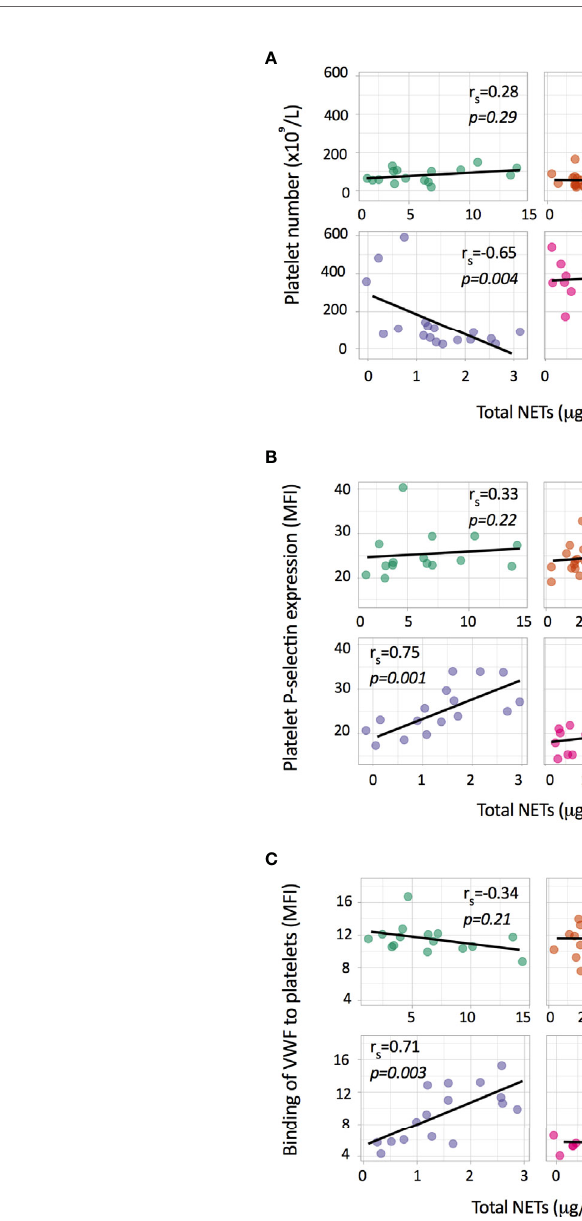
FIGURE 2 | Associations of total NETs with platelet parameters. Depicted are individual data points with the Spearman correlation between total NETs ( m g/mL) and (A) platelet number (x10 9 /L), (B) platelet P-selectin expression (MFI) and (C) binding of von Willebrand factor (VWF) to platelets (MFI). Platelet P-selectin expression and binding of VWF to platelets were measured by fl ow cytometry and are expressed as mean fl uorescence intensity